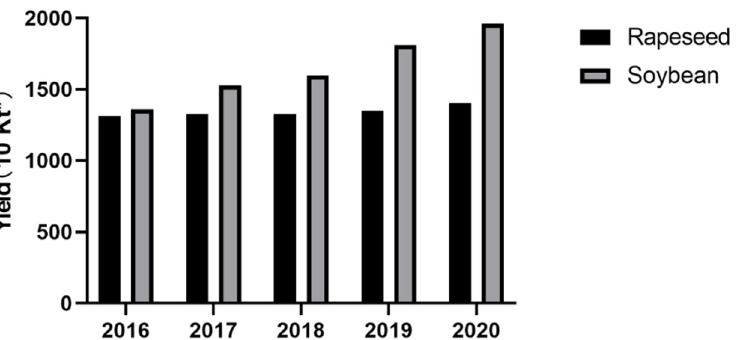
Figure 1. Soybean and rapeseed yield from 2016–2020 in China; *Kt =